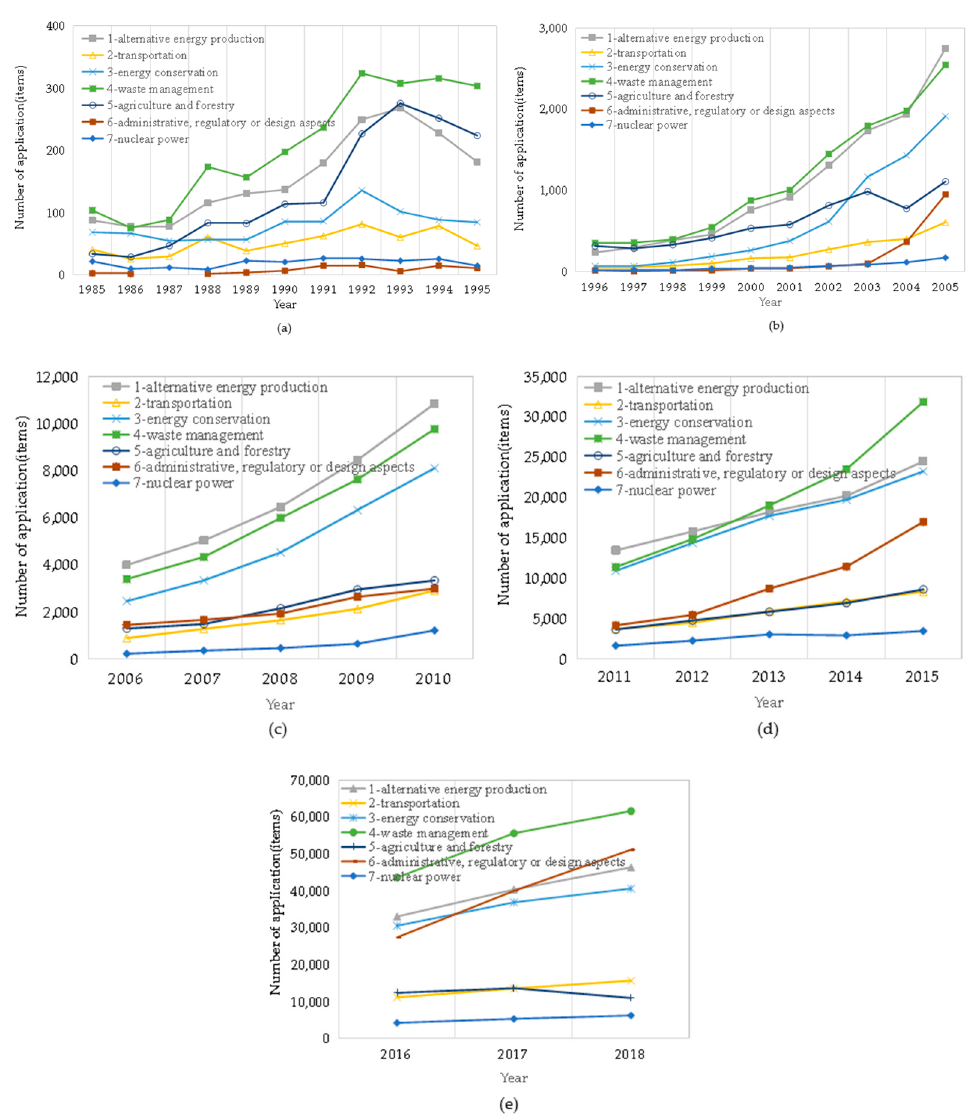
Figure 2. Number of green invention patent applications of seven categories for the period 1985–2018. ( a ): the first stage (1985–1995). ( b ): the second stage (1996–2005). ( c ): the third stage